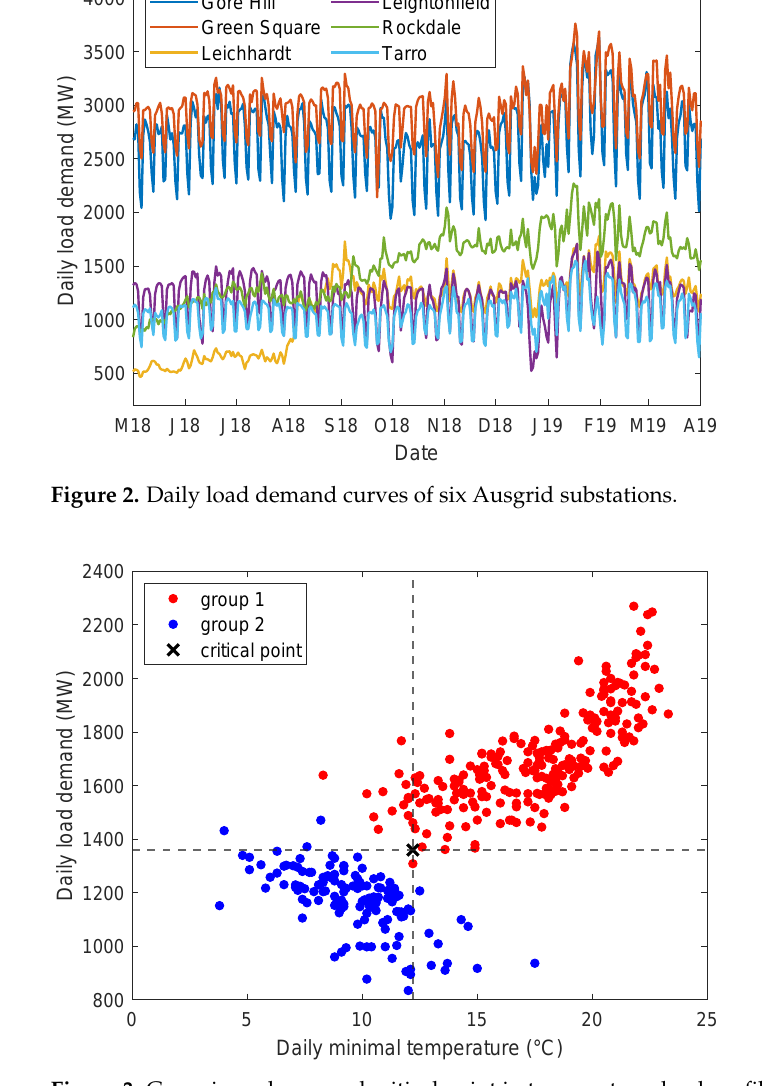
Figure 3. Grouping scheme and critical point in temperature–load